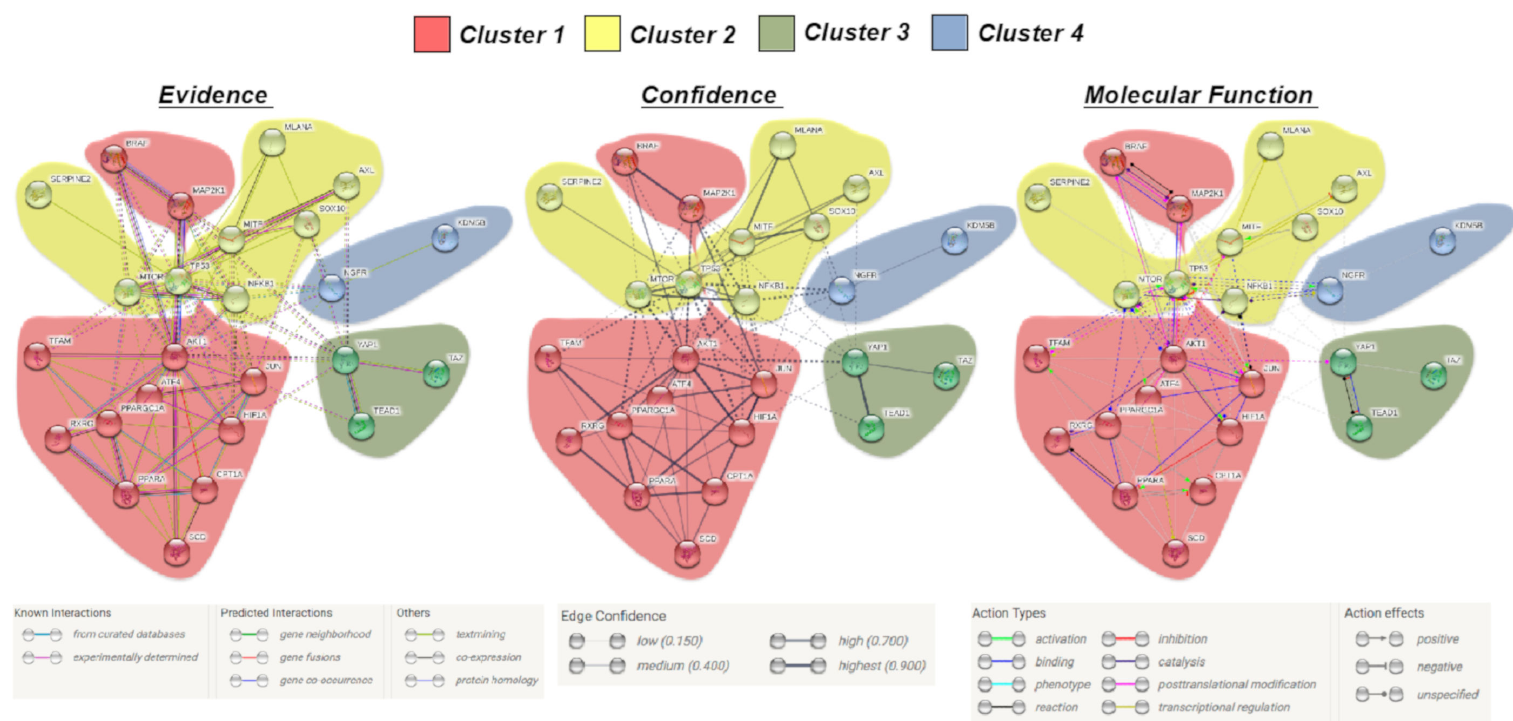
Figure 2. Evidence, confidence and molecular function-based protein-protein interaction (PPI) networks performed using the list of 25 top genes relevant for melanoma cancer stem cells (CSCs) and resistance to target therapy. The legends indicate the meaning of the lines. Interaction score applied > 0.4 (medium confidence). A total of 89 were hedges obtained with a PPI enrichment p < 1.0 × 10 –16 . https: //